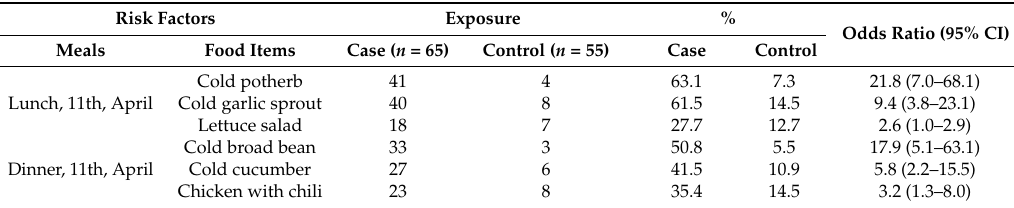
Table 2. Crude odds ratios for statistically significant association between illness and food of the norovirus outbreak on the cruise ship in China,